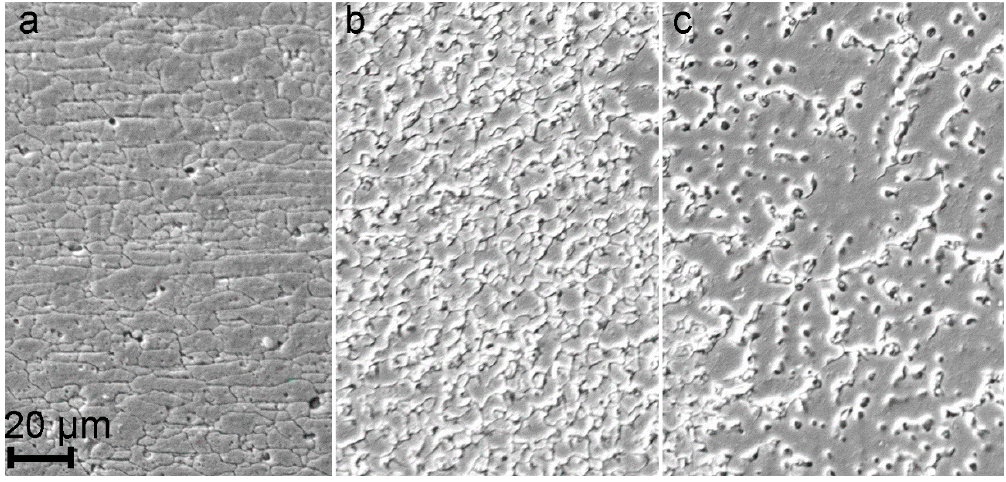
Figure 3. SEM images of BM ( a ), HAZ ( b ), and FZ ( c ) of the 1579 Al alloy weld.